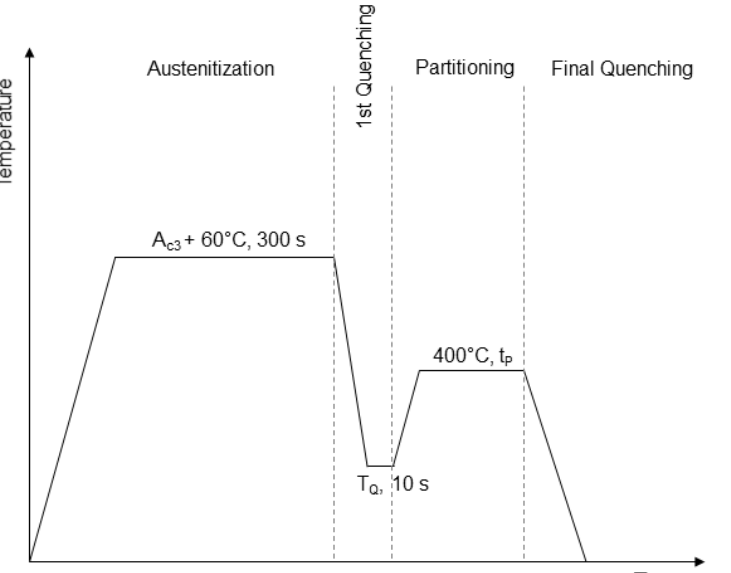
Figure 2. Schematic temperature–time diagram of the quenching and partitioning experiments for first (varying T Q and t P = 60 s) and second experimental series ( T Q = 150/170 °C and varying t P